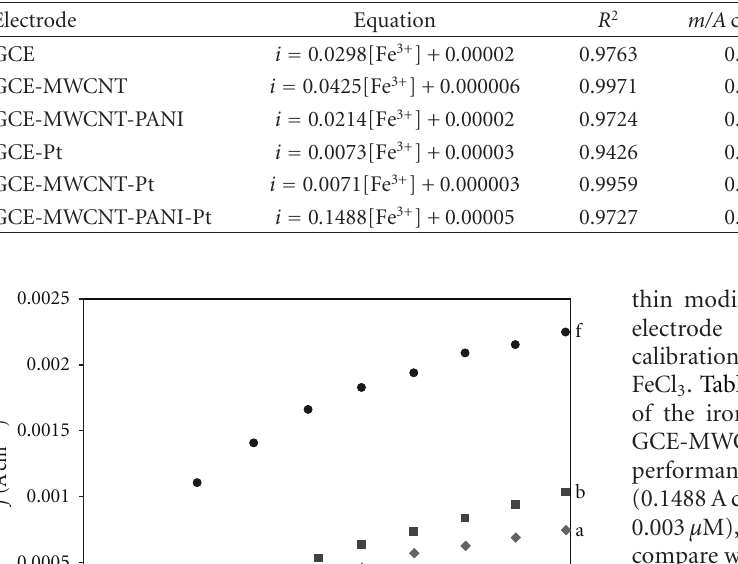
Table 2: Electroanalytical data for ionic iron electroreduction using di ff erent substrates considered in this study, in 0.1M KCl at 298 K: Glassy Carbon Electrode (GCE), Glassy Carbon Electrode-Multiwalled Carbon Nanotubes (GCE-MWCNT), Glassy Carbon Electrode- Multiwalled Carbon Nanotubes-Polyanaline (GCE-MWCNT-PANI), Glassy Carbon Electrode-Platinum nanoparticles (GCE-Pt), Glassy Carbon Electrode-Multiwalled Carbon Nanotubes-Platinum nanoparticles (GCE-MWCNT-Pt), and Glassy Carbon Electrode-Multiwalled Carbon Nanotubes-Polyanaline-Platinum nanoparticles (GCE-MWCNT-PANI-Pt), where m : slope: sensibility, σ : standard deviation, D. L.: detection Limit and Q. L.: quantification Limit.